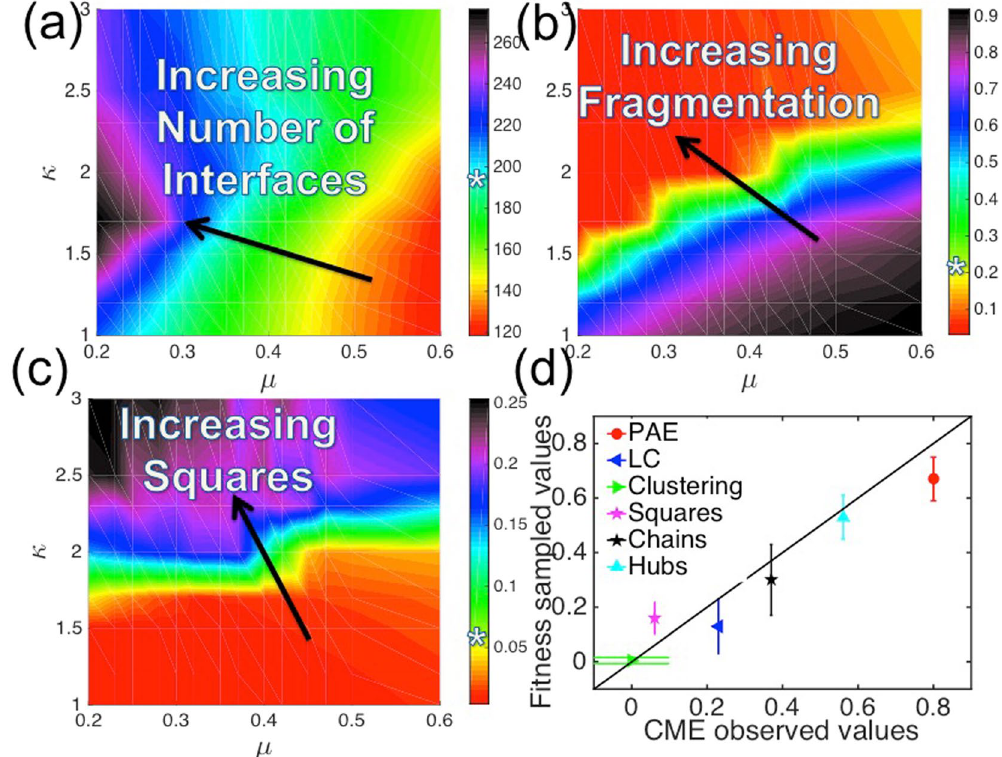
Figure 4. Learning how to select biologically realistic IINs for a PPIN using a parameterized fitness function. Because biological IINs are so distinct from a randomly generated IIN, we needed a four parameter fitness function to bias the sampling towards the correct: ( a ) number of interfaces ( b ) size of the largest module/ fragment ( c ) Frequency of square motifs in the IINs, as well as other properties (Fig. S3). The results were most sensitive to variation in the parameters κ and μ (on the axes) that regulated the square-to-chain ratios and number of interfaces, respectively, in the fitness function. White stars on color bars indicate observed values of the CME PPIN (Fig. 1a). ( d ) By training the fitness function, we achieved very good agreement between the properties of the sampled IINs and observed CME IIN with optimal fitness parameters κ = 2, μ = 0.42, β = 4 and ω = 0.1. Comparable parameters applied to the ErbB PPIN ( κ = 2.3, μ = 0.45, β = 4) except we lowered ω to 0.02 to account for the much greater frequency of edge